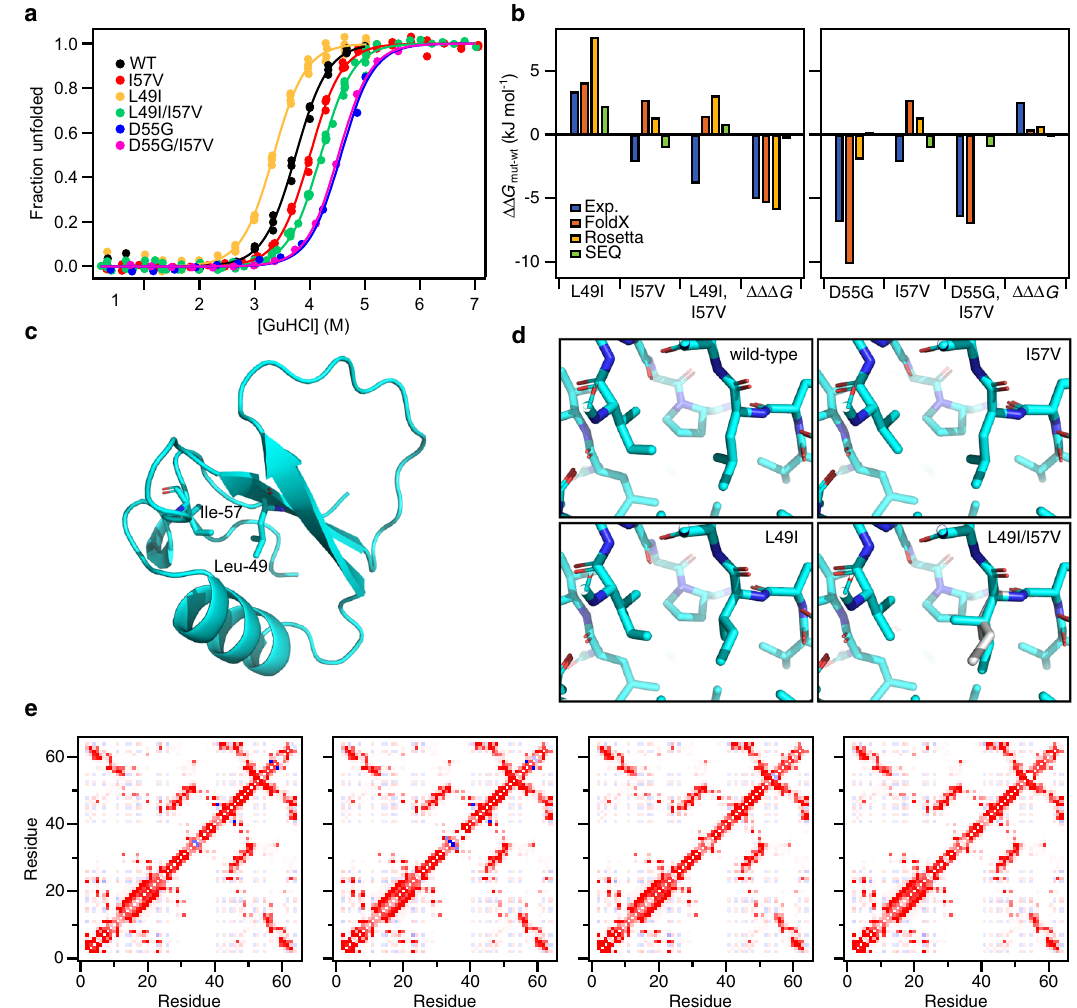
Fig. 3 Stability and structural analysis of stabilized CI2 double mutants. a Equilibrium stability curves of CI2 mutants at 25°C. The experimental data ( fi lled circles) were fi t to a model for two state folding (solid line) keeping the m -value fi xed at 8.4kJmol − 1 M − 1 . The data are here normalized to show the degree of unfolding for direct comparison and visualization only. b Differences in stability relative to wild-type CI2, ΔΔ G f , for the variants in the L49I/I57V (left) and D55G/ I57V (right) double mutant cycles. Experimental ΔΔ G f as well as ΔΔ G f predicted by FoldX, Rosetta and SEQ are shown. The ΔΔΔ G is the additional contribution to the conformational stability of the double mutants compared to the sum of the contribution of the single mutants, ΔΔ G f,mut1/mut2 − ( ΔΔ G f,mut1 + ΔΔ G f,mut2 ). The energy for the SEQ method is in arbitrary units. c Overview of the structure of CI2 with the locations of L49 and I57. d Structural details around positions 49 and 57 in the four CI2 variants in the wild-type to L49I/I57V double mutant cycle. e Residue wise contact maps. The pairwise interaction energies were calculated from AMBER FF99 using IEM 60 . The colour scale is from dark red ( − 8kJmol − 1 ) to dark blue (8kJmol − 1